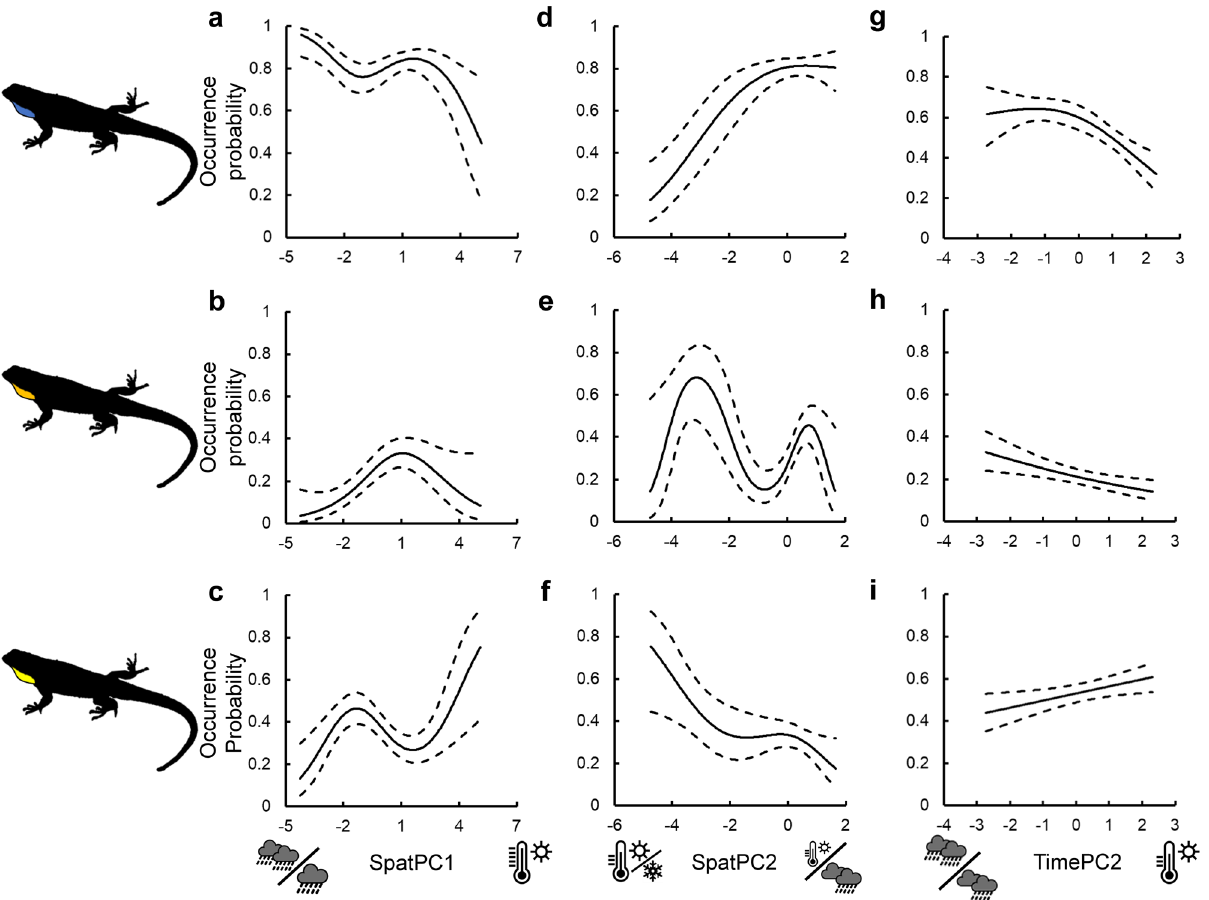
Figure 2. Predicted associations between male U. ornatus color components and climate PCs (Spatial dataset: blue [panels a , d ], orange [panels b , e ], and yellow [panels c , f ]; Time-series dataset: blue [panel g ], orange [panel h ], yellow [panel i ]) retained in the best fit model for each phenotype (broken lines: 95% CI). Model R 2 = 0.719, 0.598, and 0.406 for the spatial dataset, and R 2 = 0.697, 0.405, and 0.25 for the time-series